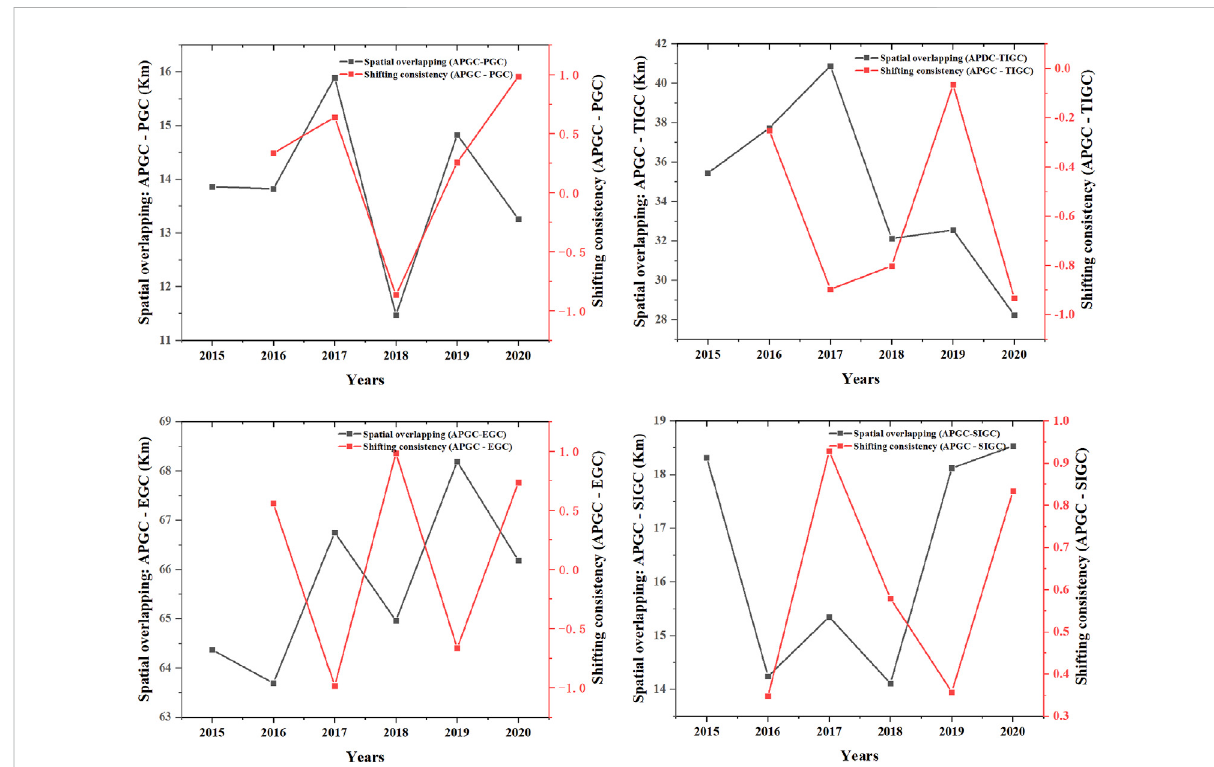
FIGURE 7 Spatial overlapping and shifting consistency indicators in the BTH region and its surrounding